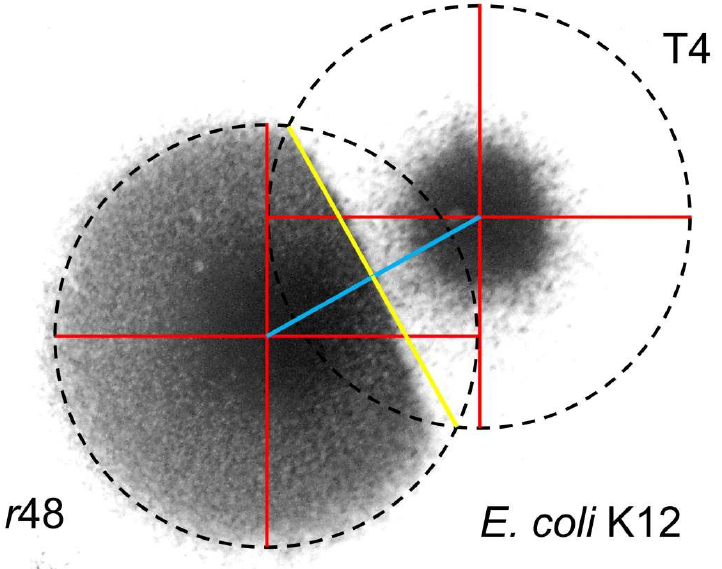
Figure 4. Colliding wild-type and r -mutant plaques, without chloroform treatment. The circles in this image are of identical size as too are the red lines, which cross at approximately the middle of each plaque. A yellow line is drawn from the intersections of the two circles, and a blue line is drawn from center-to-center of the two plaques. The intersection of those two lines (yellow and blue) coincides more or less with the limit of phage r 48 plaque growth, presumably as limited by the presence of superinfection exclusion- expressing T4 wild-type phage-infected bacteria, which would be found on the T4 side of the yellow line. Our prediction would be that the r 48 plaque would have grown to approximately the diameter of the circle in all directions in the absence of interaction with the T4 plaque. Equivalent colliding-plaque observations can be seen in the plaque photographs presented by Hershey and Rotman [78], which are based on phage T2H and E. coli strain S (which I speculate is a smooth derivative of E. coli B); see also Hershey [65] as well as Lanni [79]. The conclusion from this experiment is that the zone of infection for the phage T4 r 48 mutant and phage T4 wild-type are similar on this E. coli K12 host, else the yellow line would not so closely track the periphery of r 48